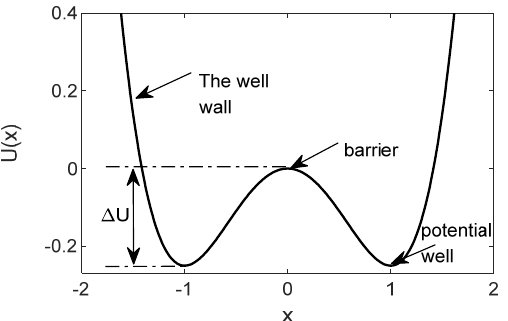
Figure 1. Potential function diagram of classical bistable model.